Question: Express in one sentence what the figure is showing.
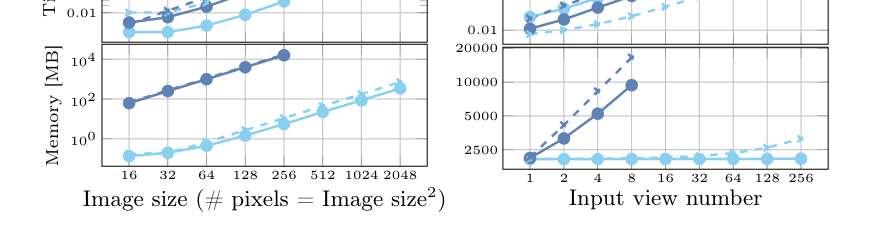
Answer: Lightplane memory & speed benchmark showing the forward (FW and backward (BW) passes of Lightplane Renderer (left) and Splatter (right), compared to the Autograd renderer and lifter from [11, 98]. Lightplane exhibits up to 4 orders of magnitude lower memory consumption at comparable speed. All axes are log-scaled.